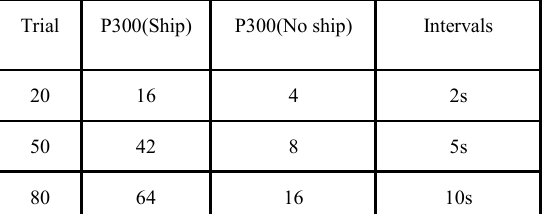
Table-4. P300 aha-moment potential computation results for Ships dataset.